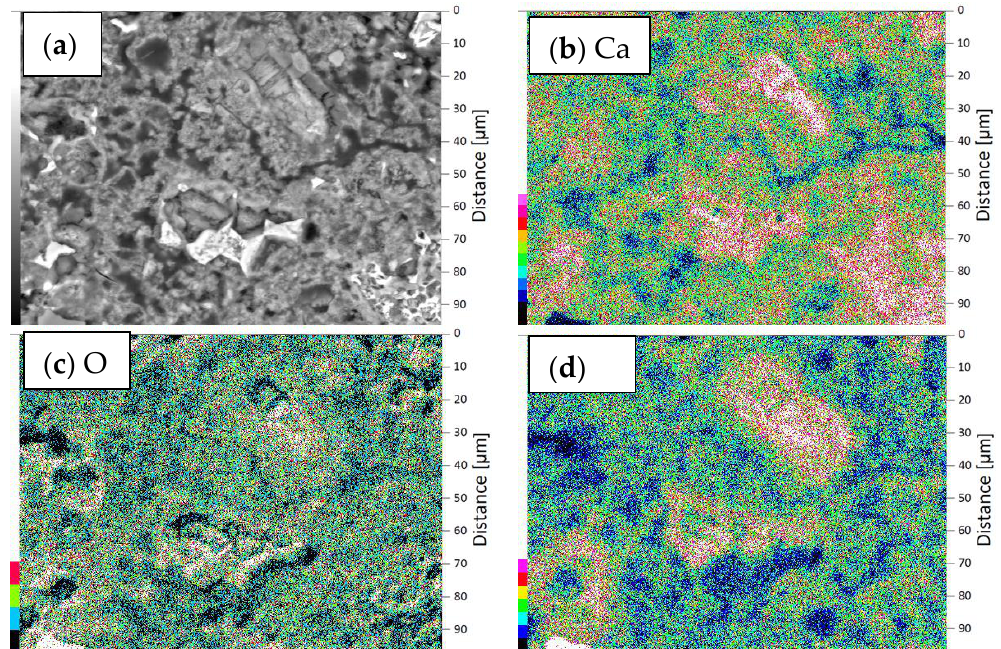
Figure 18. EDX mappings of chemical elements in the subsurface layer of the substrate of the sample modified with 0.5 wt % of polypropylene fibers: ( a ) area of the performed distribution, ( b ) images of Ca incidence, ( c ) images of O incidence, ( d ) images of Si incidence.